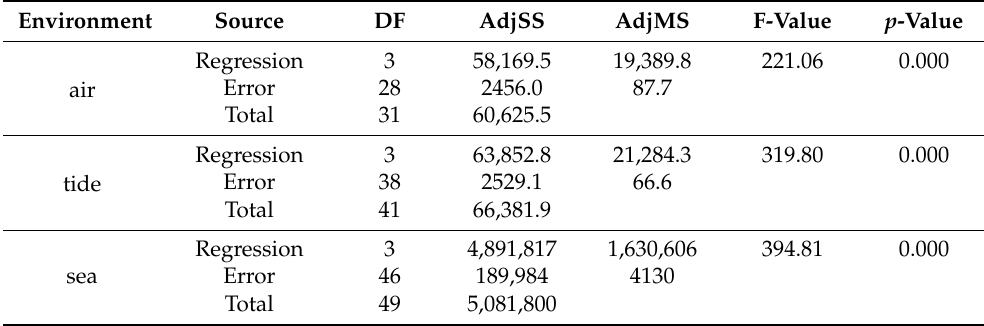
Table 6. The regression analysis of variance for the NiTi1 alloy samples for the three observed types of marine